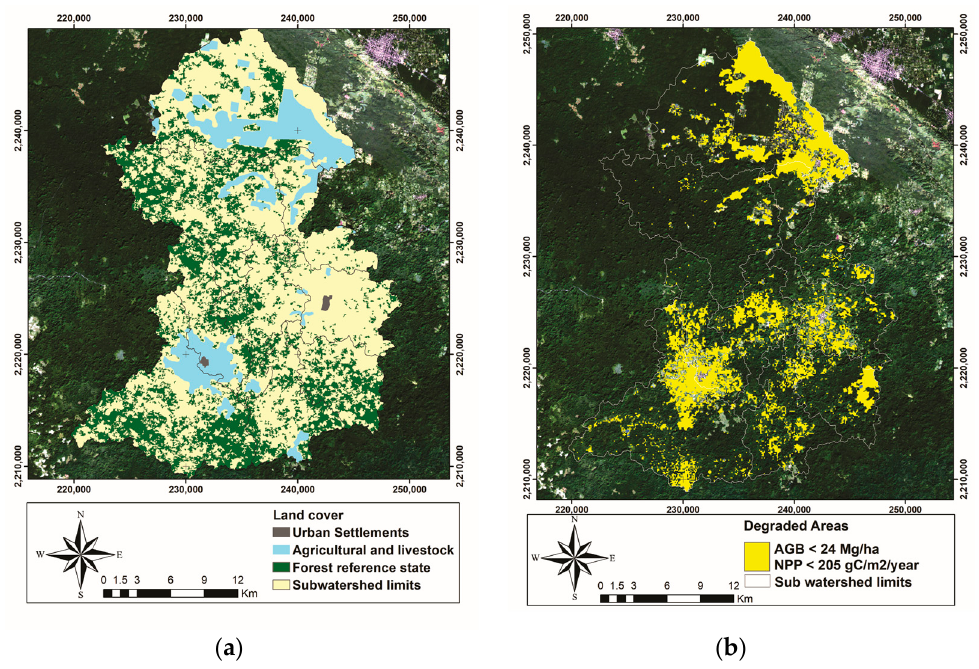
Figure 6. ( a ) Forest cover used as a reference state; ( b ) Forest-degraded areas according to the indicators selected.